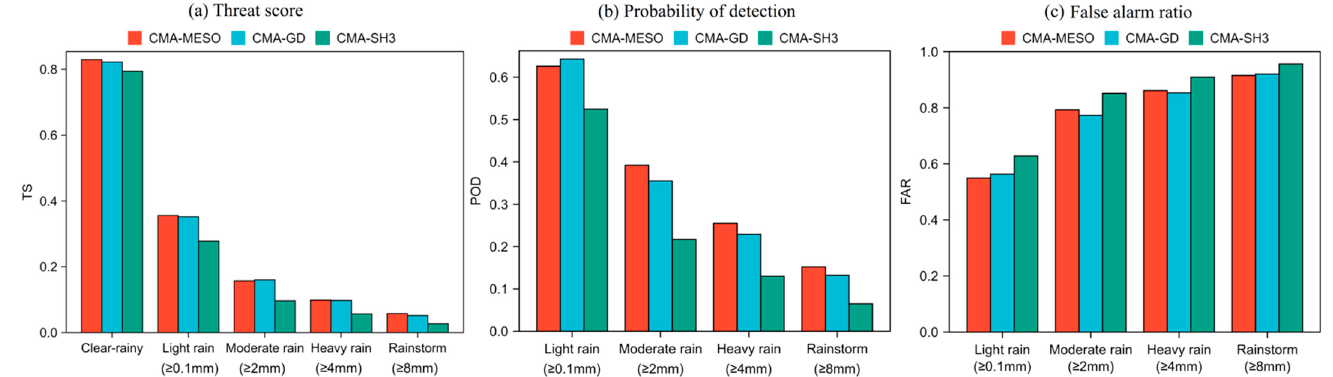
Figure 4. Assessment of multi-model hourly QPF. The calculation equations are shown in Table 5.